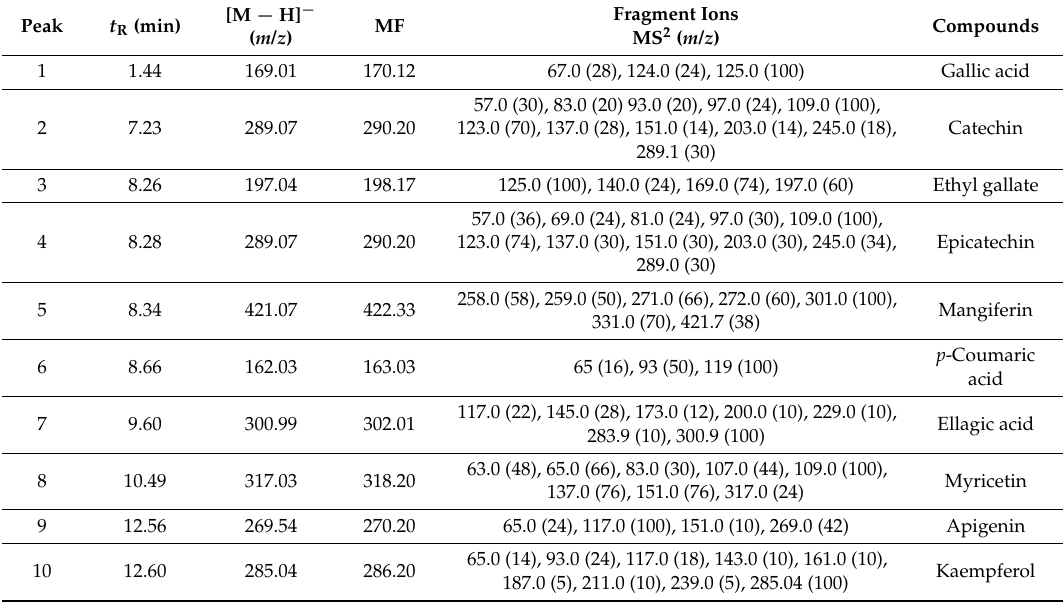
Table 5. Chromatogram and spectral properties of compounds detected in ethanol extracts of peel and seed kernel extract from M. odorata fruit by by LC-ESI-Orbitrap-MS/MS. Peak